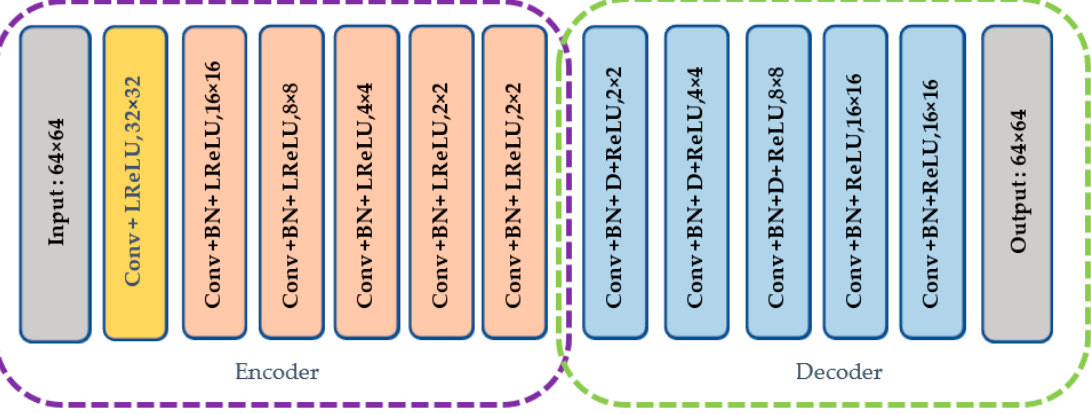
Figure 2. Architecture of generator.